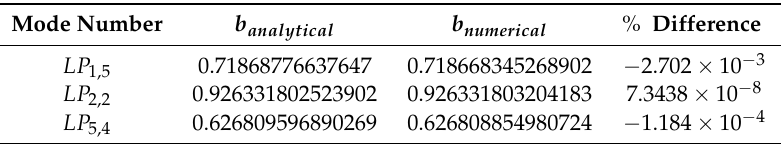
Table 2. Comparison between the propagation constant estimates for both the analytic and numerical approaches to step index